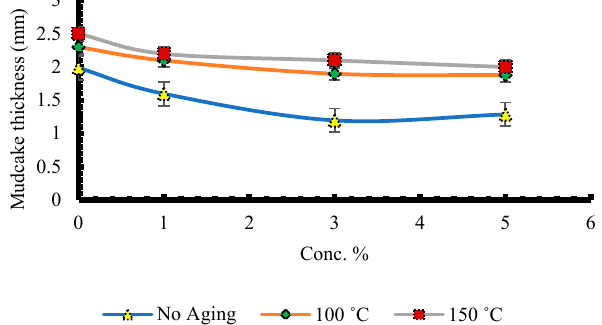
Figure 4. Comparison of filtrate volume of NADES-based mud with other inhibitors.